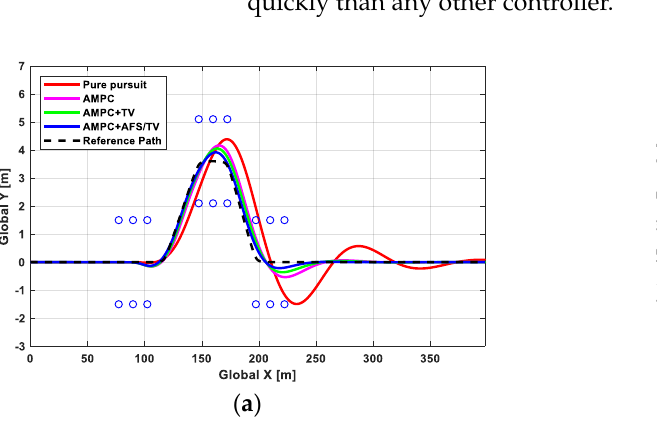
Figure 5. Double lane-change scenario.